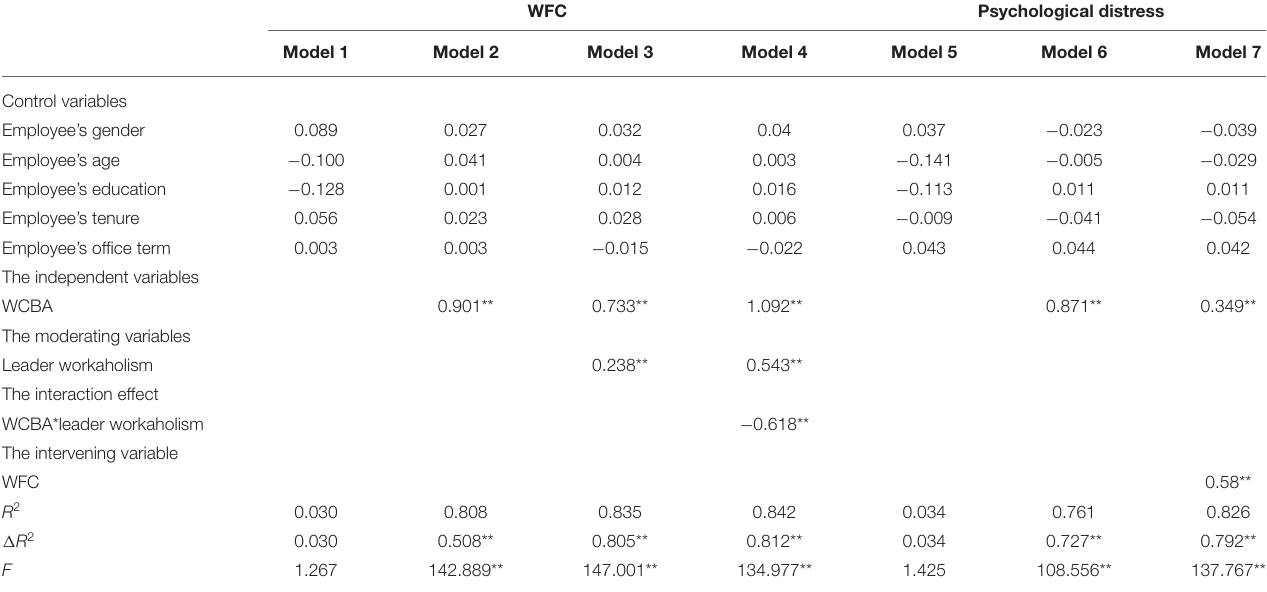
TABLE 3 | Summary of stepwise regression